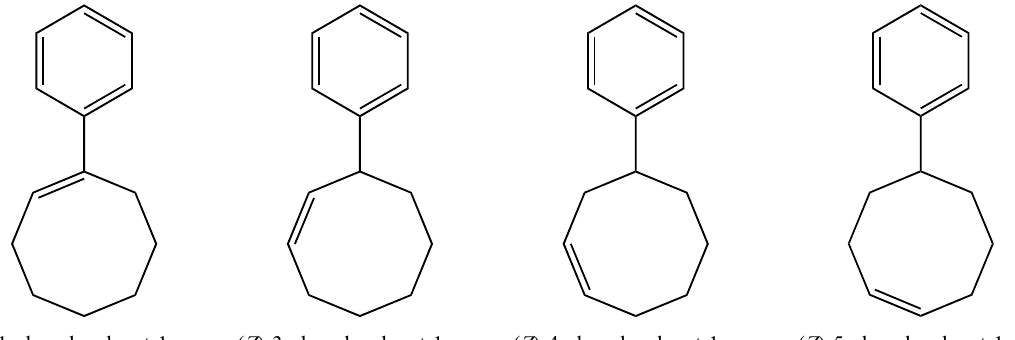
Figure 21. Possible product structures for the coupling reaction between phenylboronic acid and cis - cyclooctene.